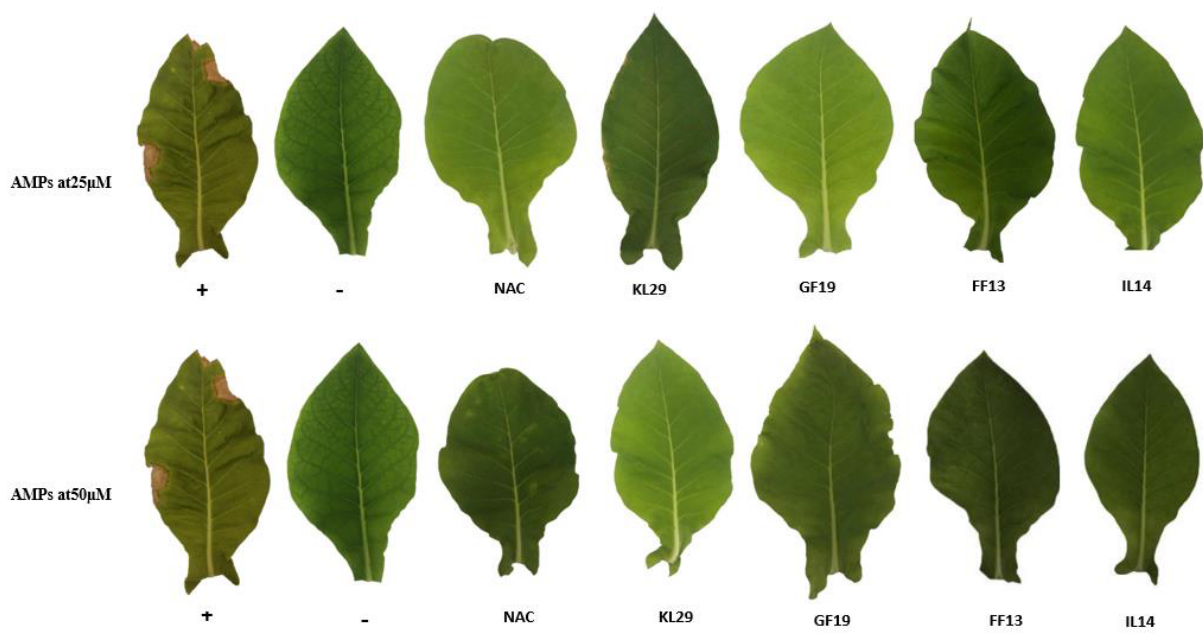
Figure 8. Tobacco leaves showing the interaction between AMPs and Xf at 45 dpi. +: Xf -infected tobacco leaf showing scorch symptoms at 30 dpi; -: untreated tobacco leaf showing no symptoms. NAC — N-acetyl-L-cysteine-treated Xf -infected leaf showing no symptoms, used as a positive con- trol treatment.